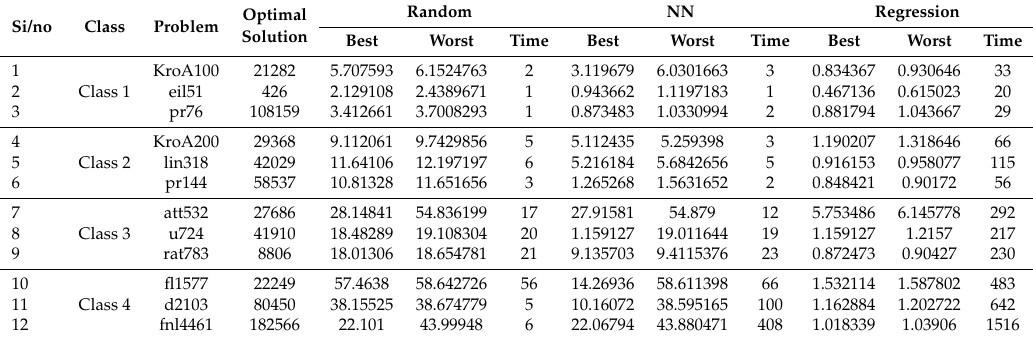
Table 3. Experimental results with respect to the Error Rate (%) for different population seeding